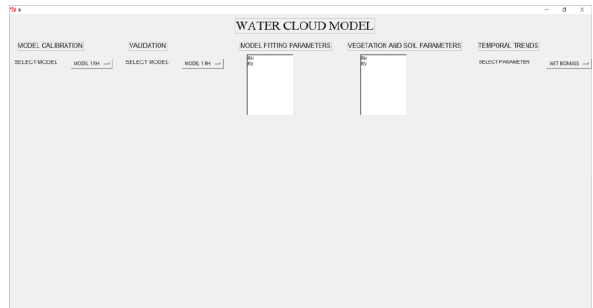
Figure 7. GUI for the